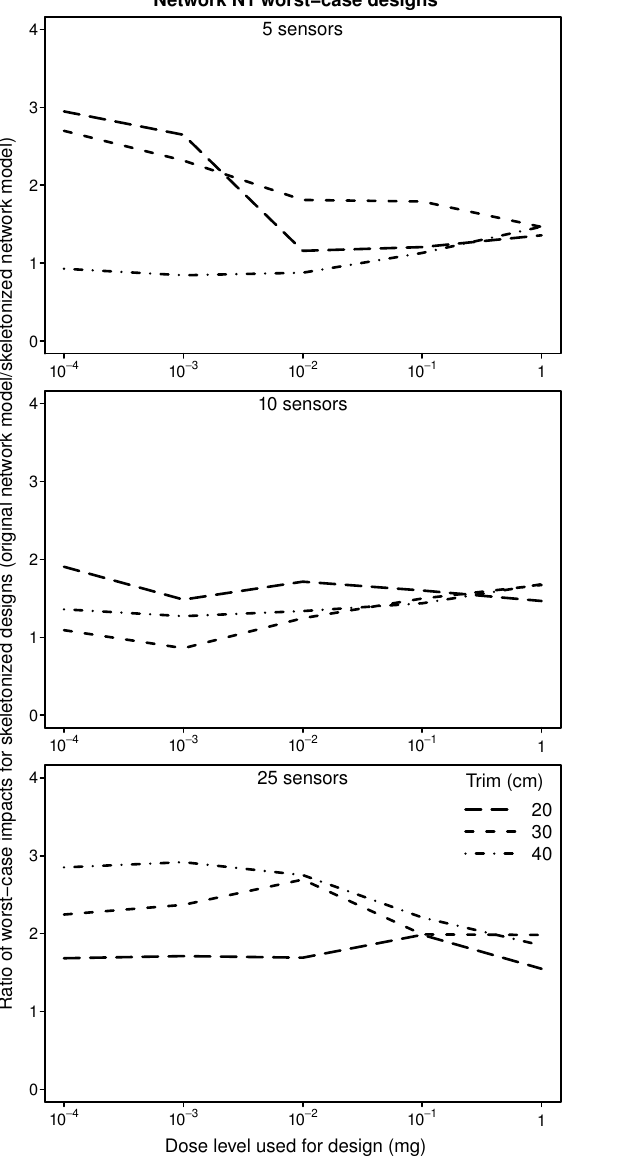
Figure 4. Reduction in worst-case impacts obtained with original and transplanted worst-case CWS designs for Network N1 relative to impacts obtained when no CWS is used. Results are shown for the original model and three levels of network skeletonization